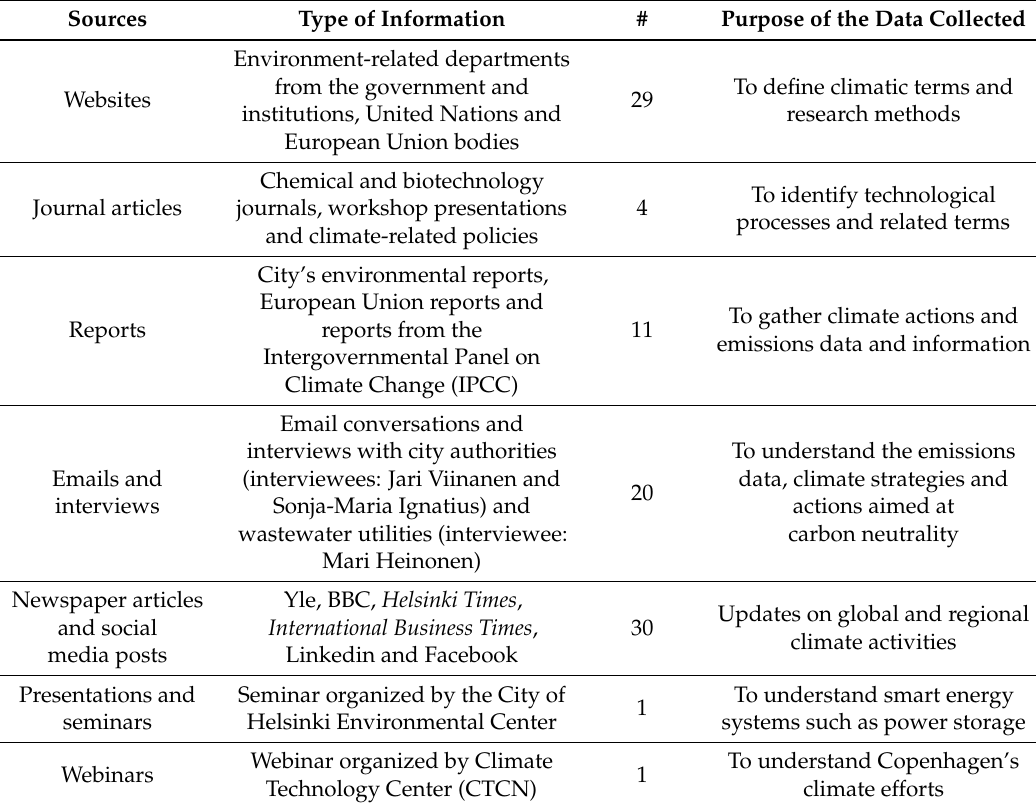
Table 1. Data collection